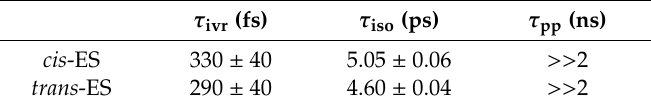
Table 2. Summary of the lifetimes of dynamical processes of cis -ES and trans -ES. Reproduced and adapted with permission from [114], licensed under CC BY 3.0. Published by the Royal Society of Chemistry.